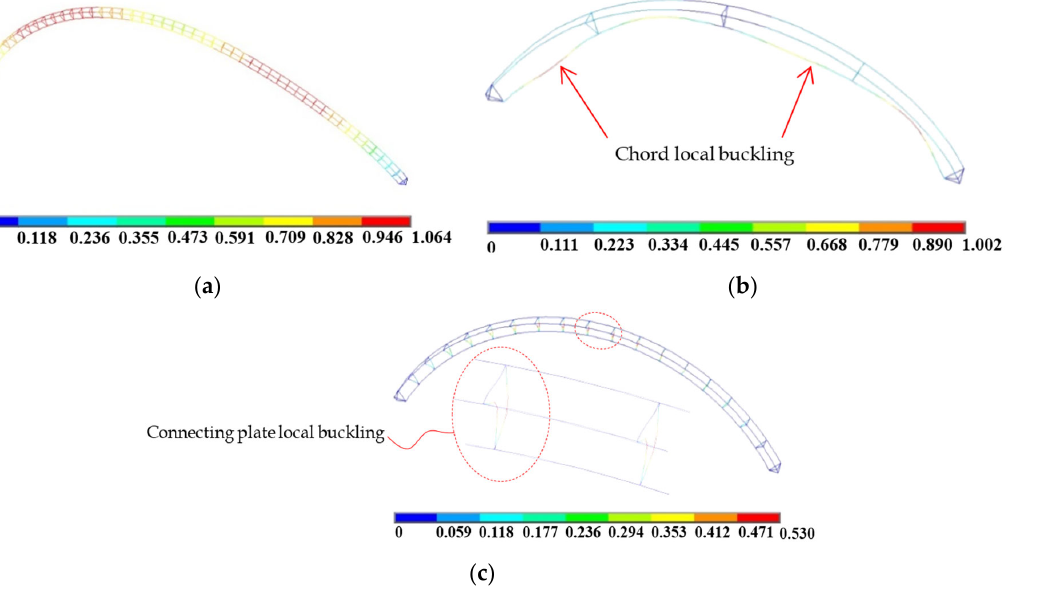
Figure 7. Three kinds of buckling modes of the arch: ( a ) global elastic buckling of the arch; ( b ) local chord buckling of the arch; ( c ) local connecting plate buckling of the arch. Table 1. Model parameters of different buckling modes of the arch.